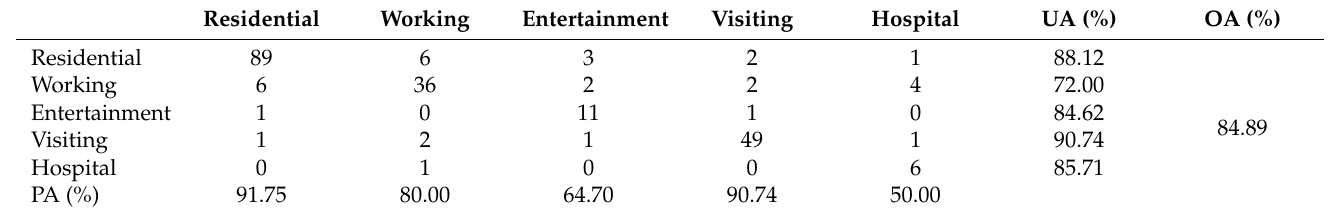
Table 6. Confusion matrix of the MS-RF model-predicted BFTs versus reference BFTs for the test sample